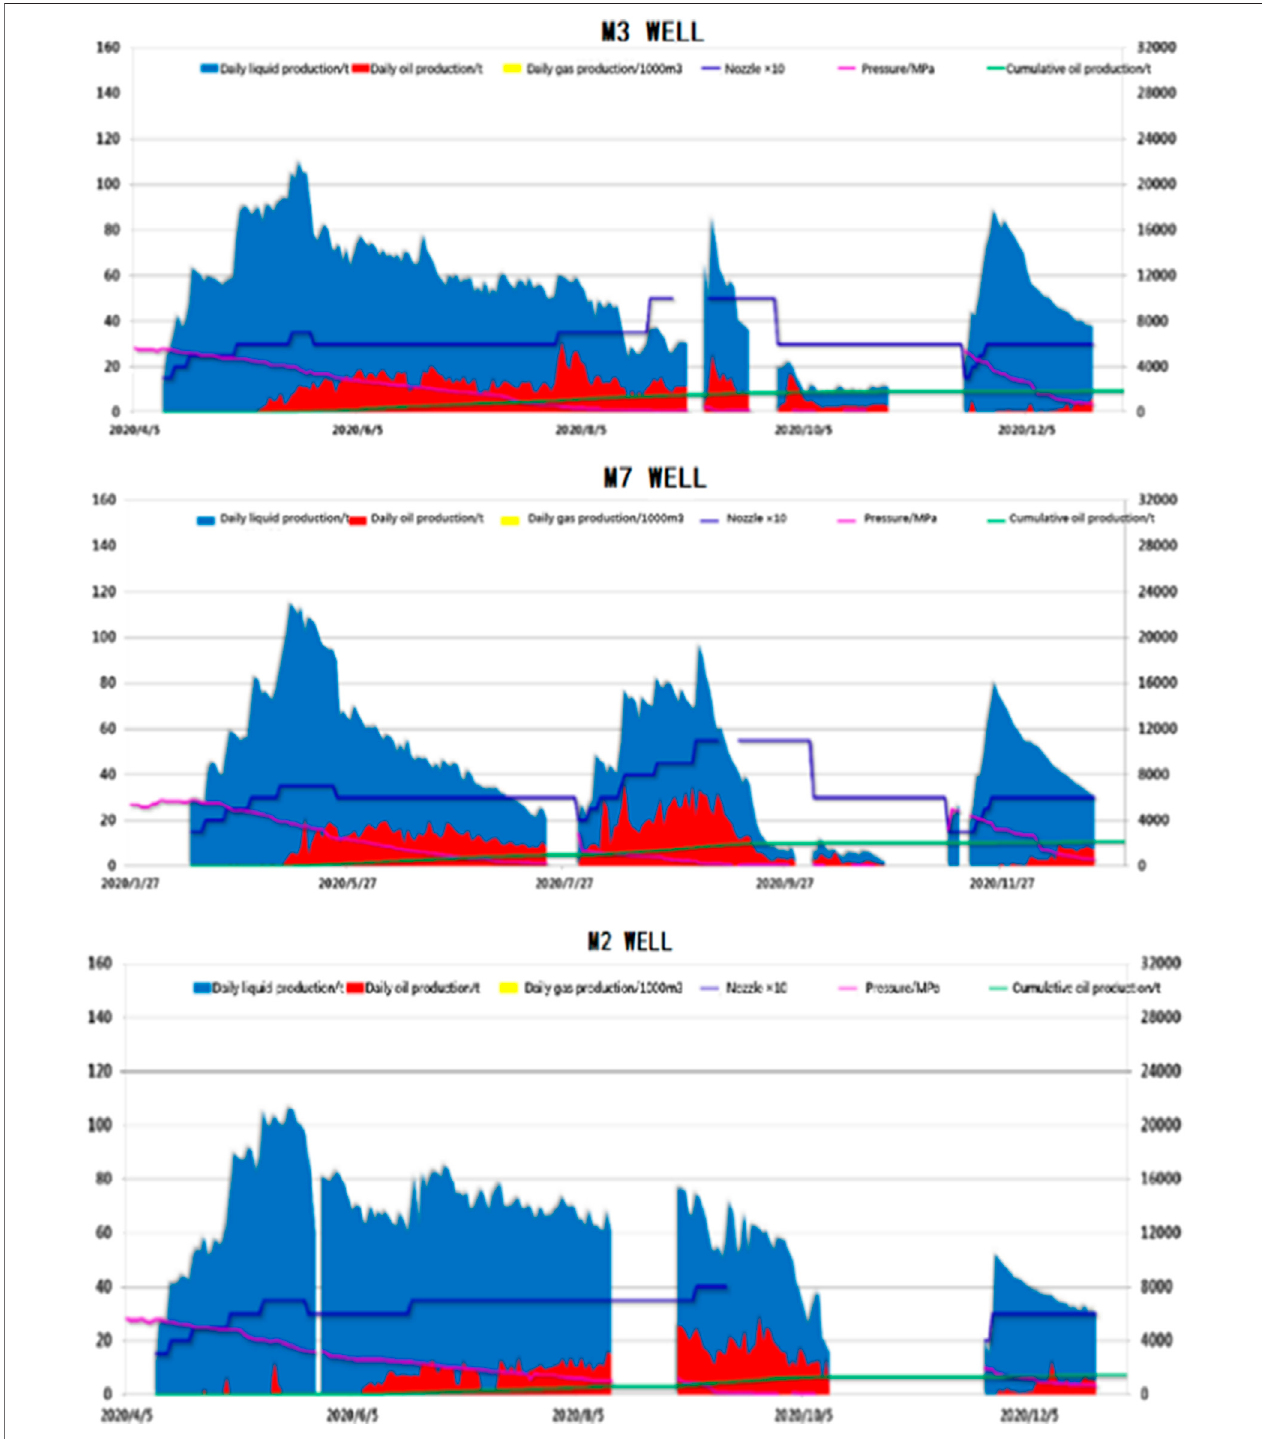
FIGURE 14 | Well M3, M7, and M2 production curve (from top to bottom)